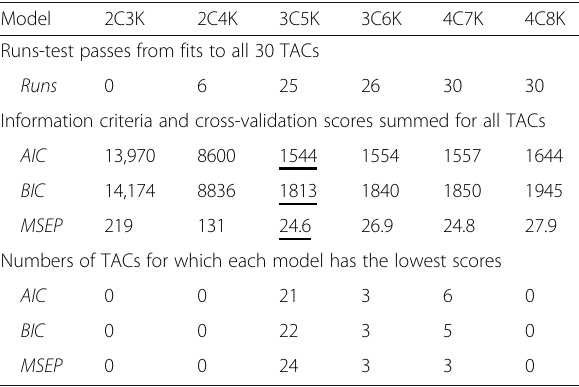
Table 2 Summary of runs-test results and totaled AIC, BIC, and MSEP scores for compartment model fits to all 30 whole tumor FMISO TACs. Lowest totaled AIC, BIC, and MSEP scores are underlined, indicating the best model according to those measures